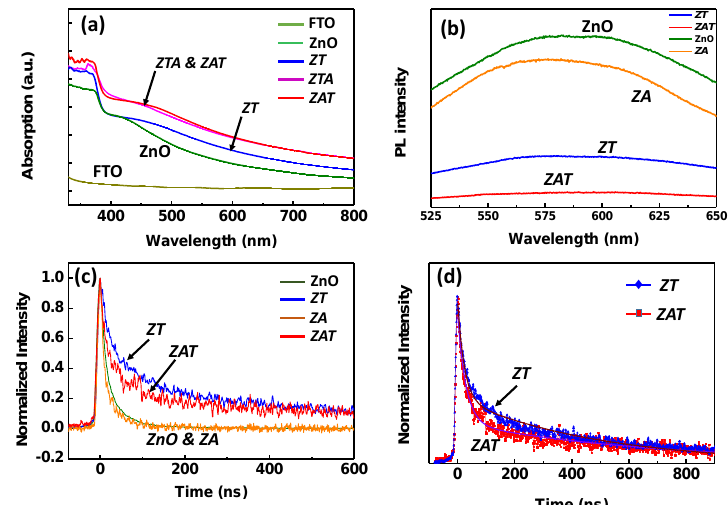
Figure 7. ( a ) UV-Vis absorption spectra of the corresponding samples; ( b ) Comparison of PL spectra of corresponding samples; ( c ) TRPL analysis of ZnO nanorod arrays, ZT , ZA , and ZAT structure with normalized intensity; ( d ) TRPL analysis and its fitting of ZT and ZAT structure. The excitation-lasers used in PL and TRPL tests have λ = 355 nm, and the laser pulses with power of 3.75 μJ/cm 2 were employed for the TRPL tests. The zero point of the y -axis is at the level of the x -axis in panels ( a , b , d ).